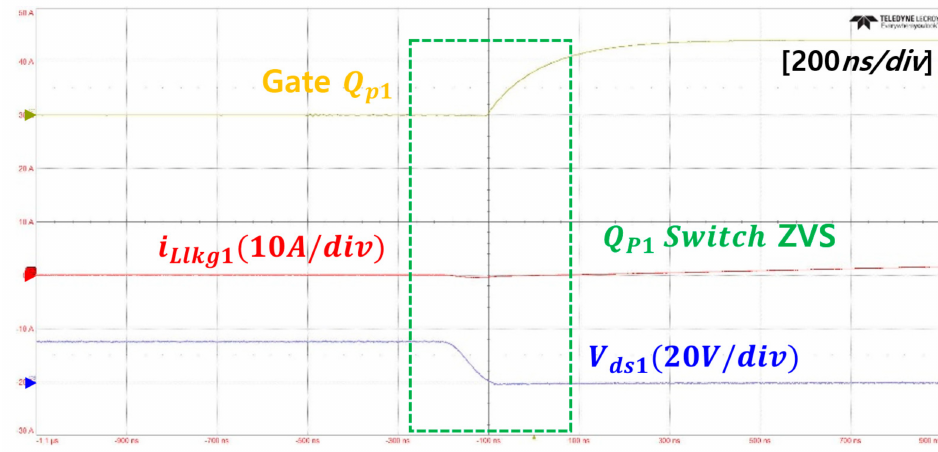
Figure 13. ZVS waveform under 100% load conditions.